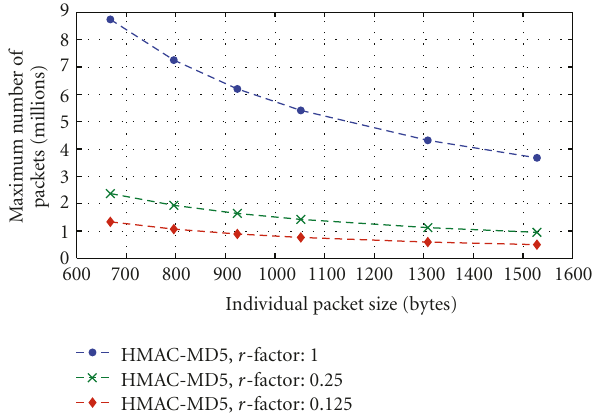
Figure 13: Total number of packets processed by source authenti- cation protocol with HMAC-MD5 on iPAQ H3670.